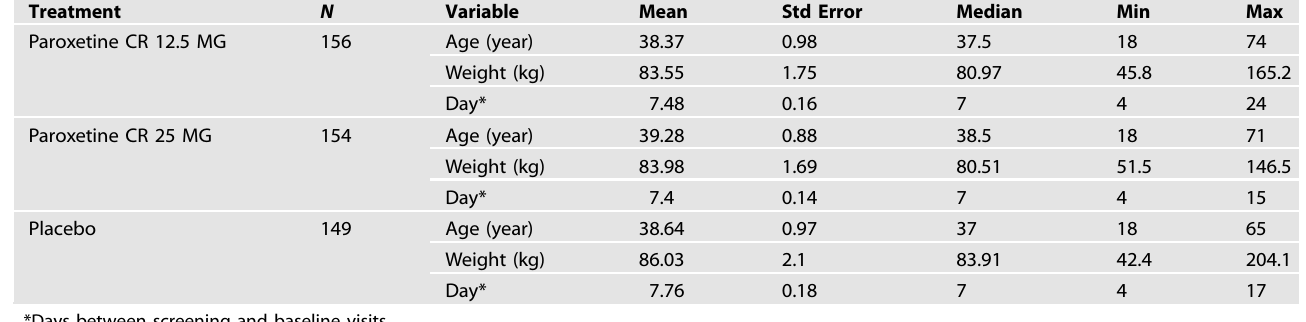
*Days between screening and baseline visits.